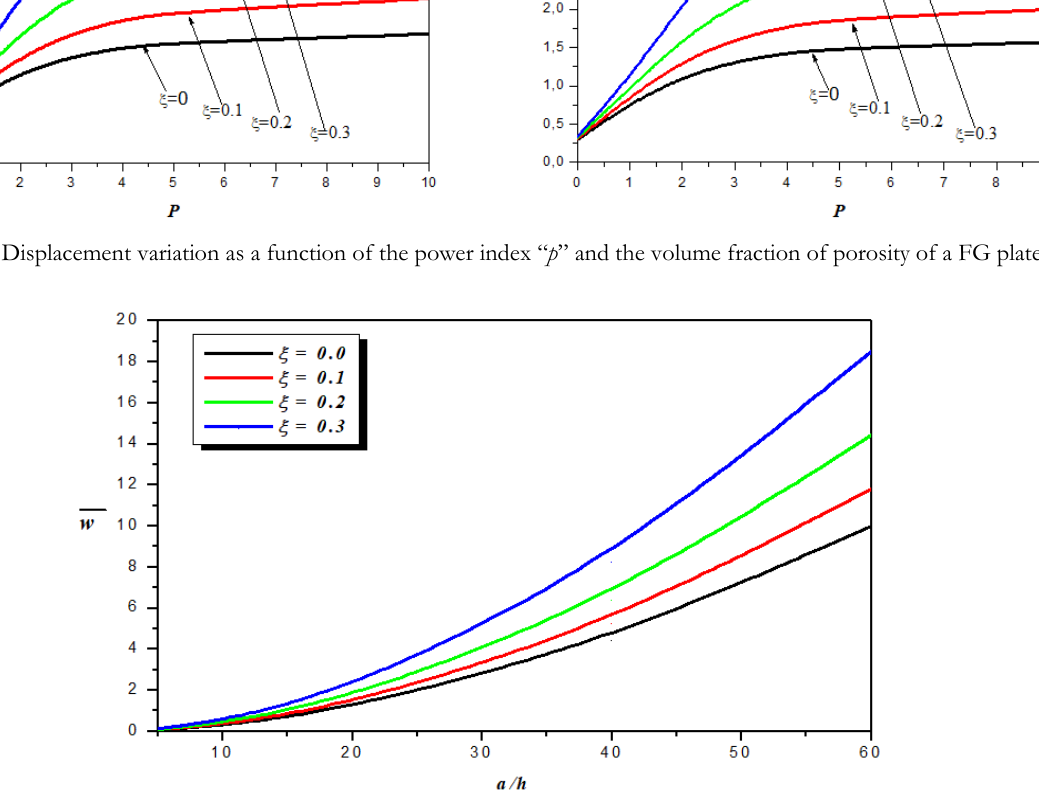
Figure 3: Displacement Variation depending on the thickness ratio (a/h) for various porosity factor values ξ